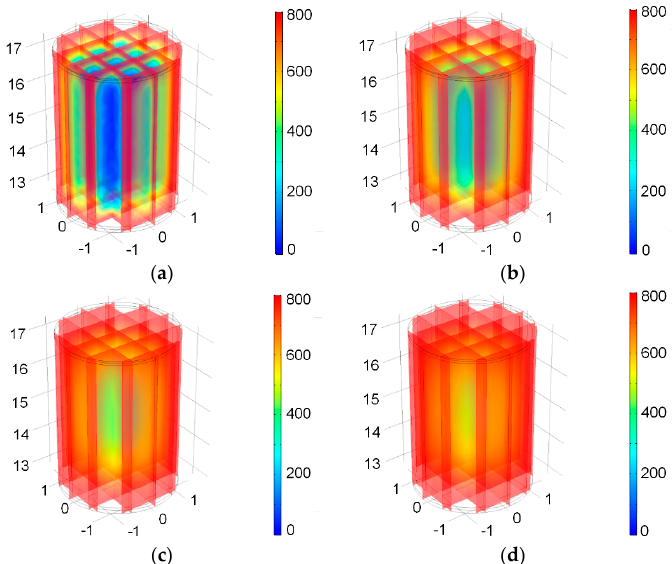
Figure 1. Sketch of thermal faults simulation system.